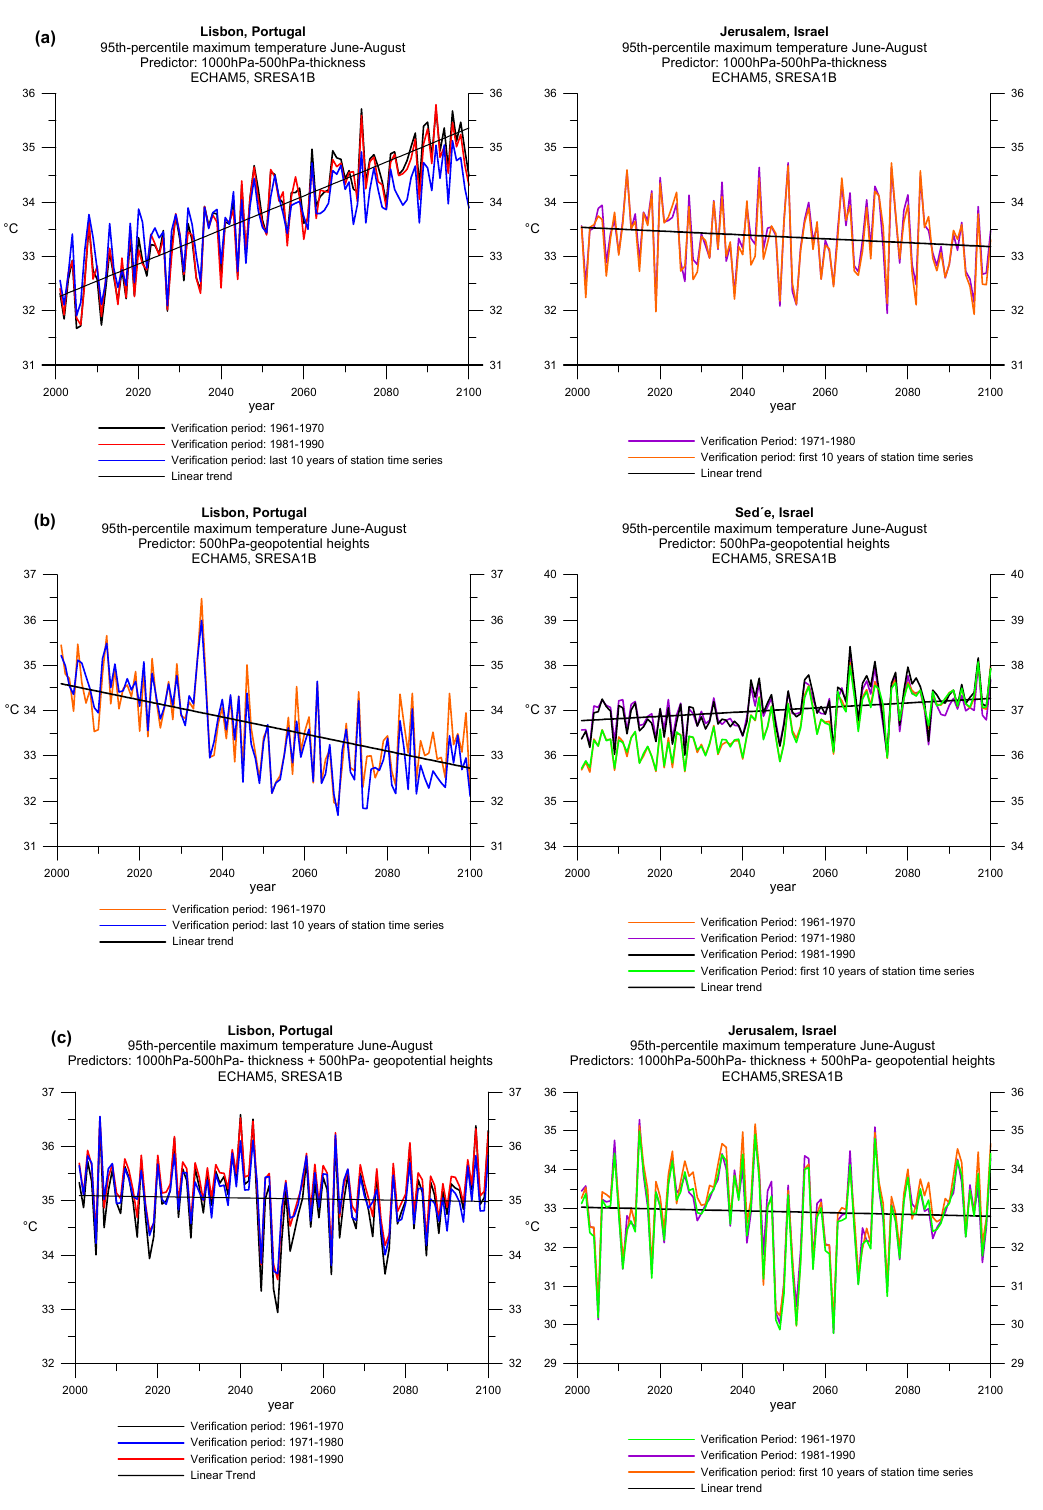
Fig. 5. Time series and linear trends of multi-member statistical downscaling ensembles of extreme (95th percentile) maximum tempera- ture in summer 2000–2100 for three different predictors/predictor combinations ( (a) 1000hPa–500hPa-thickness, (b) 500hPa-geopotential heights, (c) 1000hPa–500hPa-thickness and 500hPa-geopotential heights) for the station of Lisbon, Portugal (left side) and the station of Jerusalem (for (b): Sed’e), Israel (right side). Predictor values are from the ECHAM5/MPI-OM model run under SRESA1B scenario assumptions. The statistical downscaling technique is multiple regression